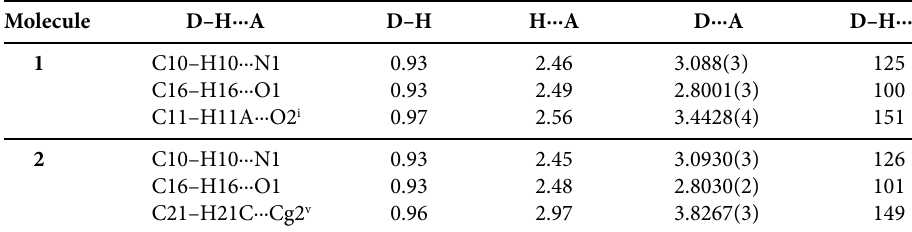
Figure 1. (a) The molecular structure of the compounds 1 and 2 with atom numbering scheme and 30% probability displacement ellipsoids and (b) optimized structures for DFT/ B3LYP/6-311G(d,p) level. Table 3. Hydrogen bonds (Å, °).